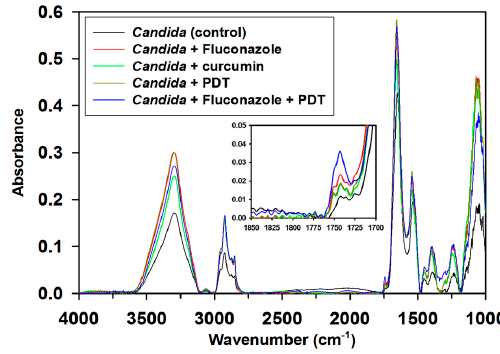
Figure 7. Fourier transform infrared (FT-IR) spectra of C. albicans before the treatment and after the